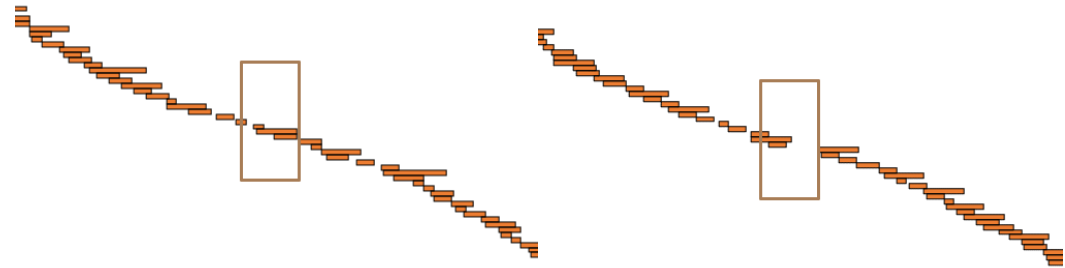
Figure 12. Before and after Gantt diagrams of the demand response event, respectively, from period 848 to period 1058.